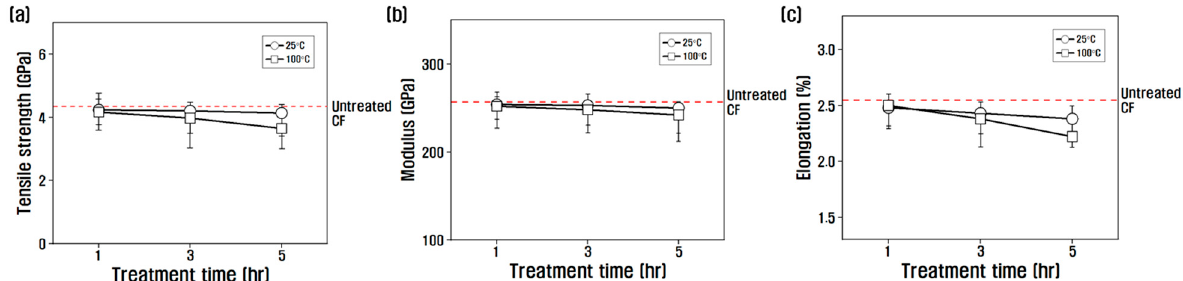
Figure 2. Effect of chemical treatment according to temperature and treatment time on the tensile properties of carbon fiber ( a ) tensile strength and ( b ) modulus ( c ) elongation.